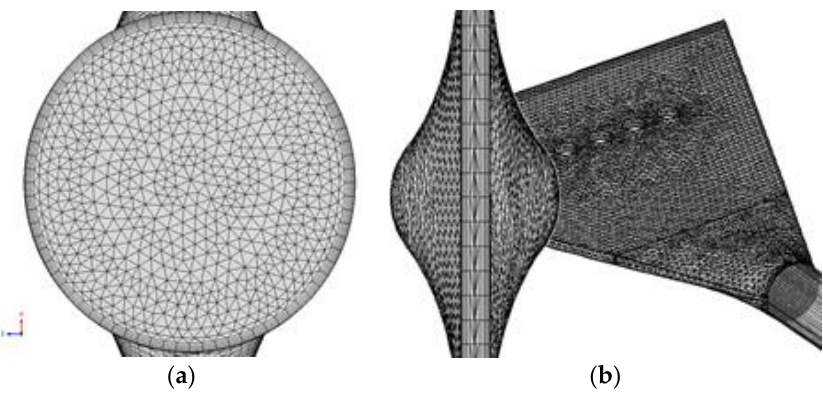
Figure 3. Grids system: ( a ) tube section, and ( b ) diffuser section.